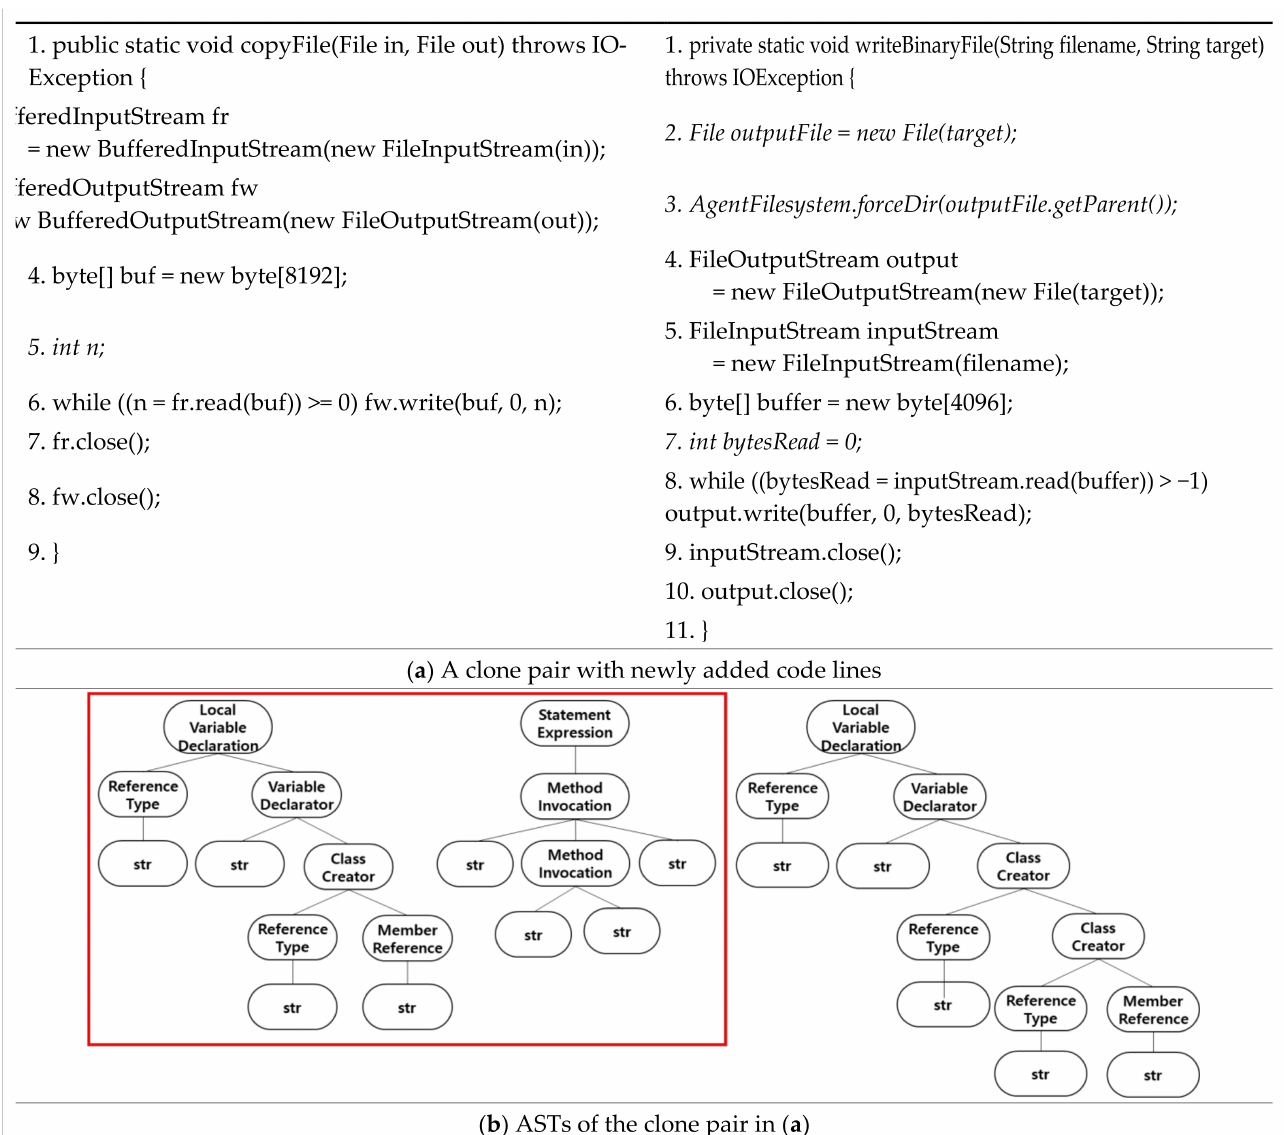
Figure 6. Example of MT3 clone classified as ST3